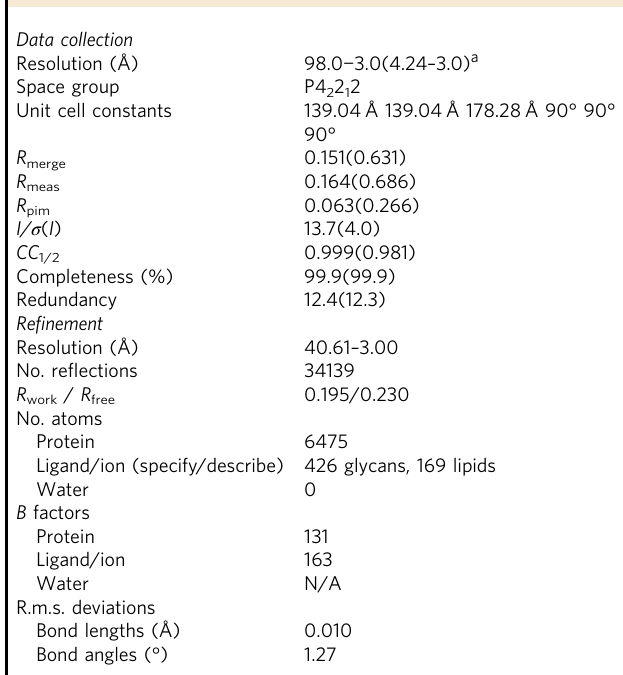
Table 1 X-ray crystallography data collection and re fi